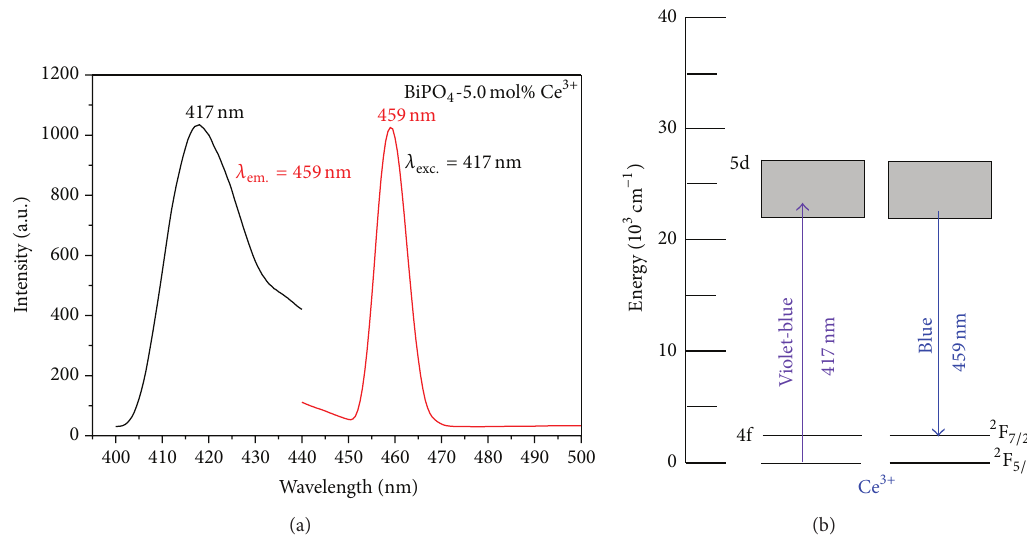
Figure 5: (a) PLE and PL spectra of 5.0 mol% singly Ce 3+ doped sample and (b) corresponding energy level diagram.